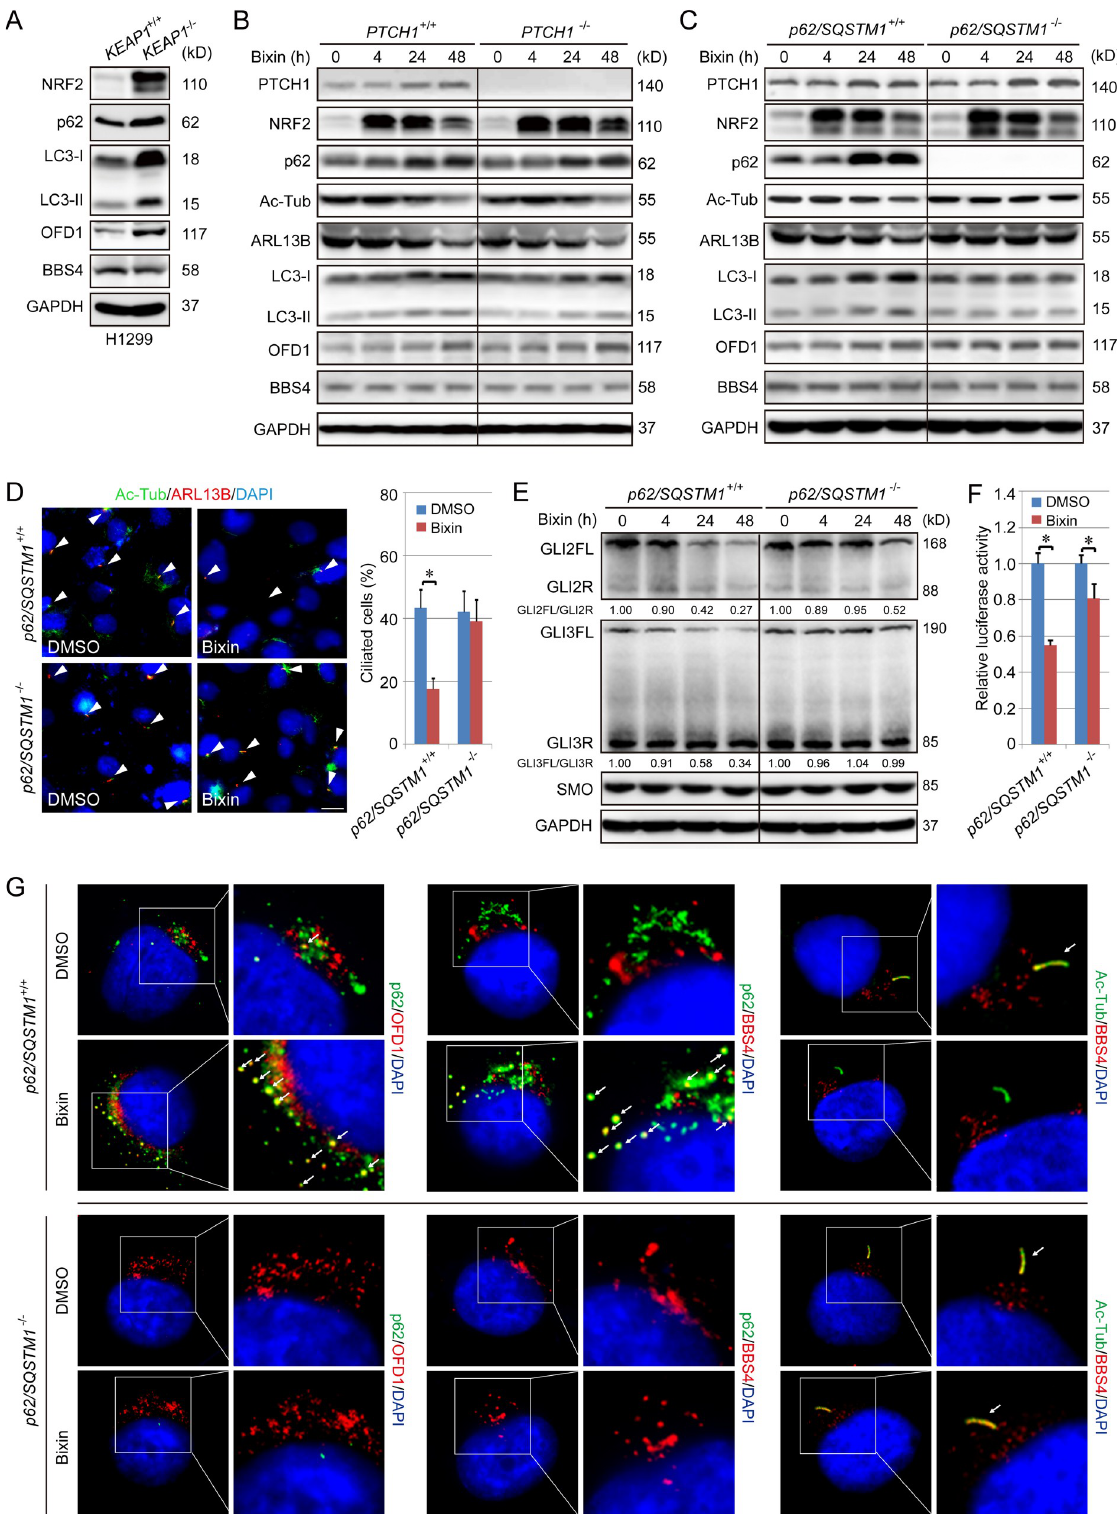
Fig 5. NRF2 inhibits ciliogenesis by increasing p62-dependent inclusion body formation and suppressing the ciliary entrance of BBS4. (A) Immunoblot analysis of p62, LC3-I and II, OFD1, and BBS4 in KEAP1 +/+ and KEAP1 − / − H1299 cells. Relative quantification of